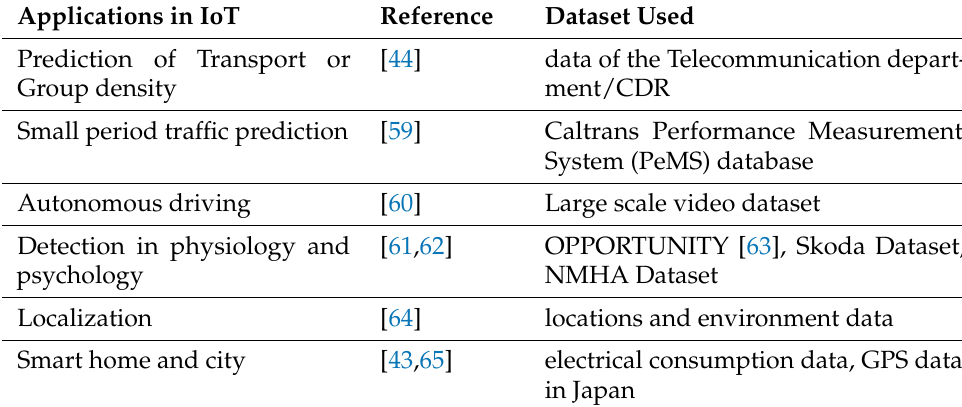
Table 2. LSTM model in IoT